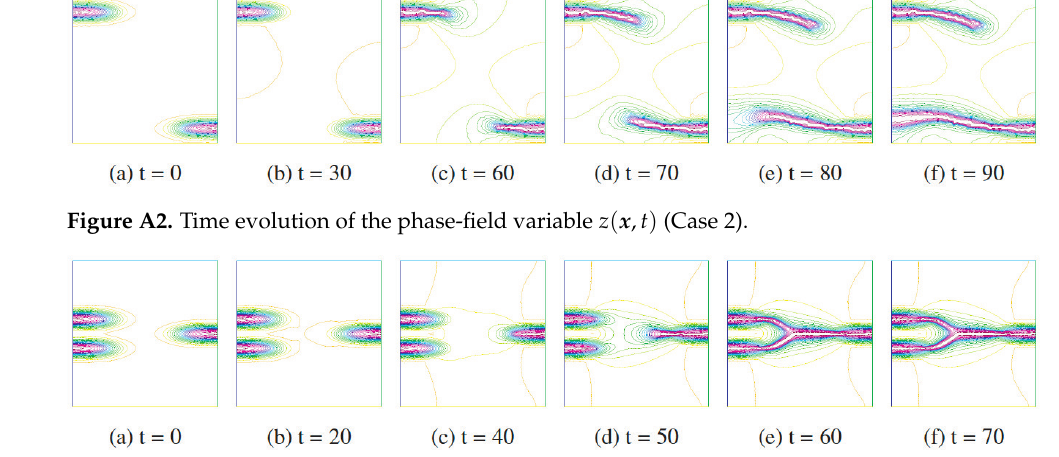
Figure A3. Time evolution of the phase-field variable z ( x , t ) (Case